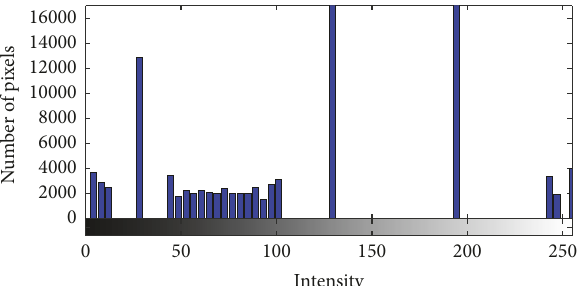
Figure 19: The histogram with equalization.